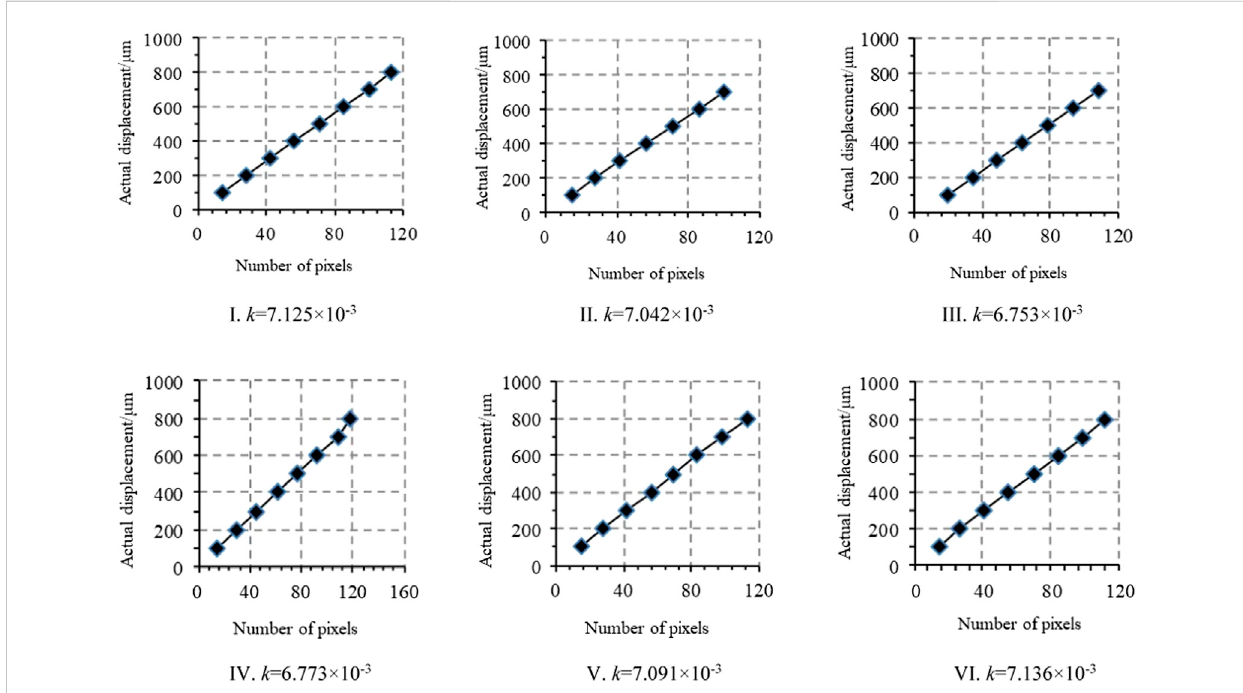
FIGURE 6 Results of the loading test (the left fi gure shows the comparison between calculated stress and loading stress; the right fi gure shows the calculated stress direction).